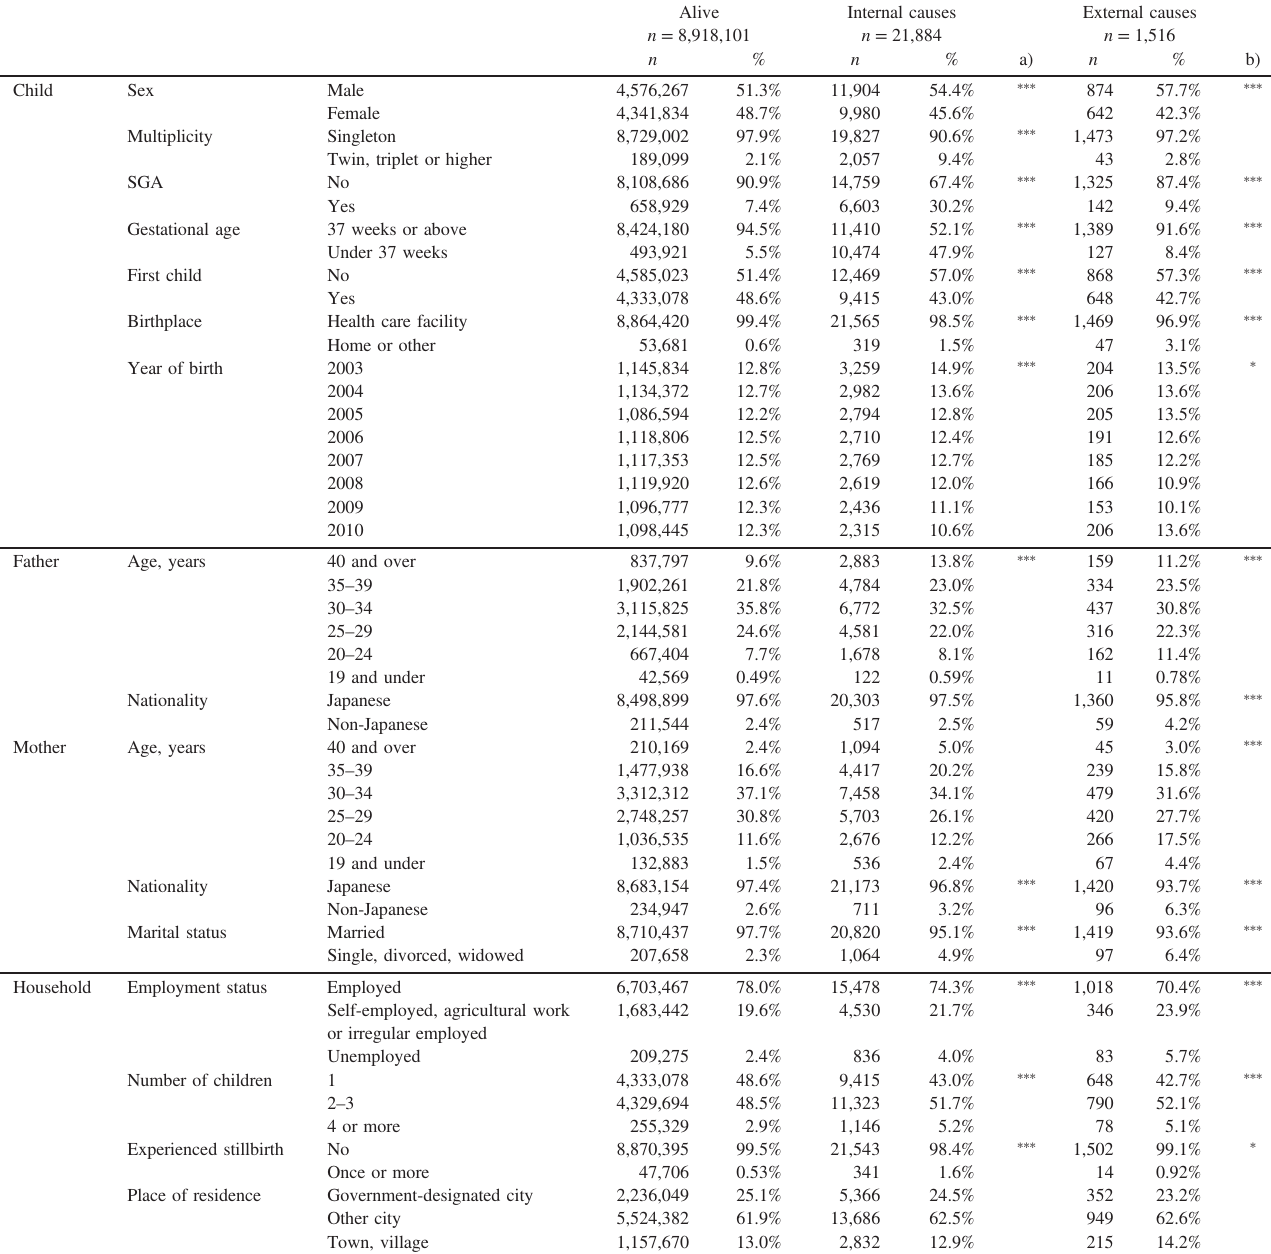
Table 2. Child, parent and household characteristics of infants who survived until their fi rst birthday, infants who died due to internal causes, and infants who died due to external causes among 8,941,501 infants born in Japan in 2003 –